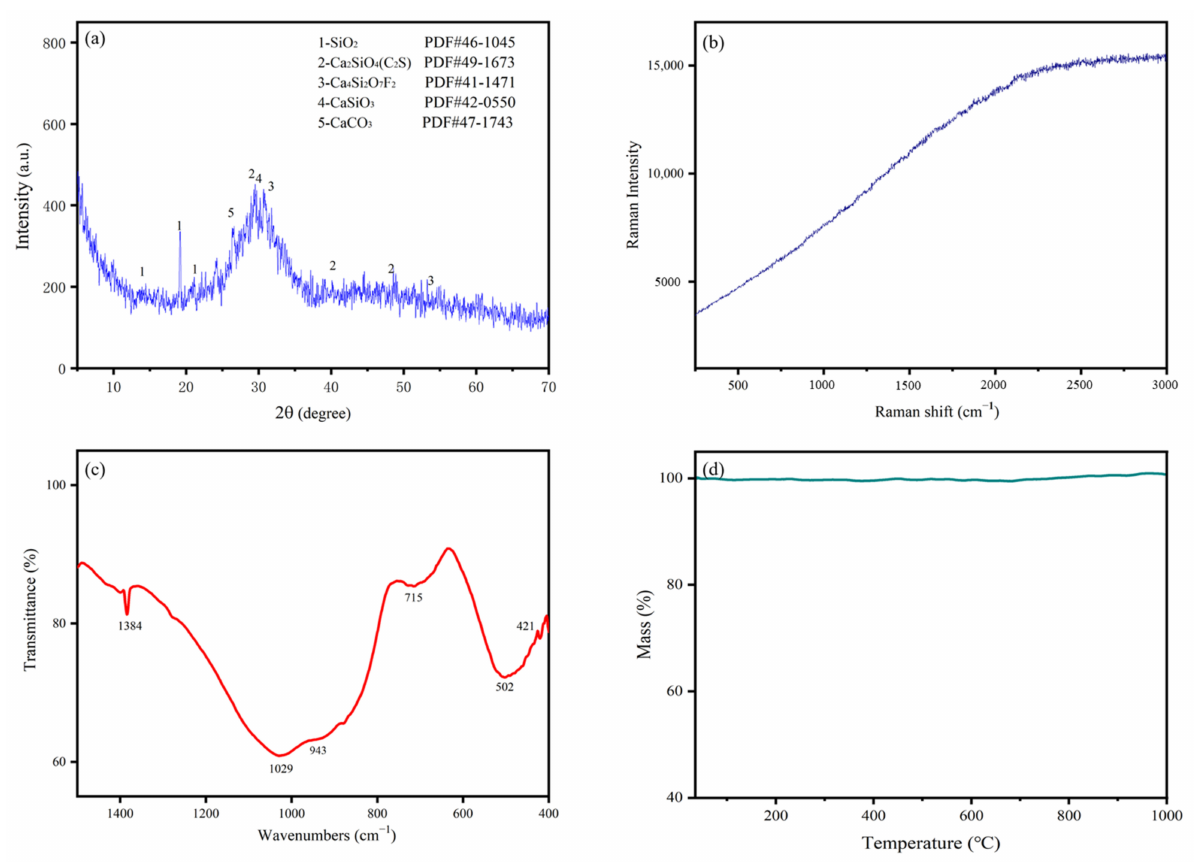
Figure 2. Basic characterization results of phosphorous slag: ( a ) XRD; ( b ) Raman; ( c ) FT-IR; ( d )